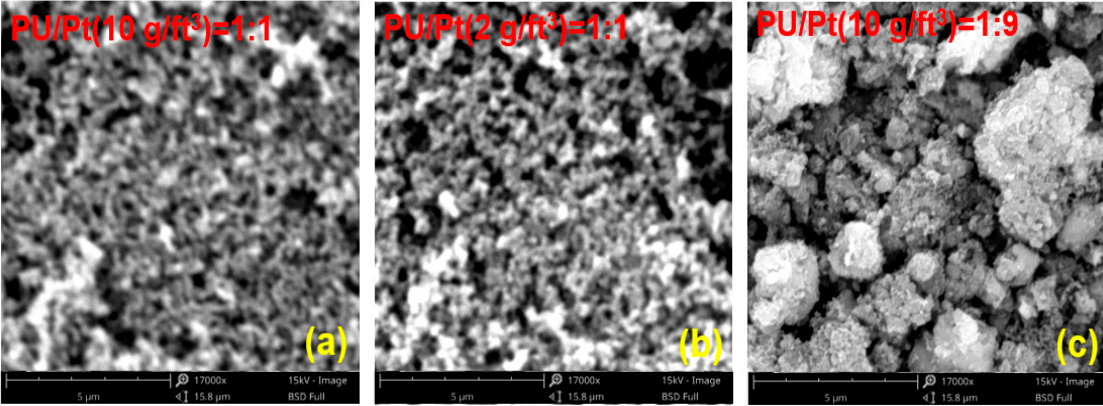
Figure 5. SEM diagrams in no aging experiments: ( a ) PU/Pt (10 g/ft 3 ) = 1:1; ( b ) PU/Pt(2 g/ft 3 ) = 1:1; ( c ) PU/Pt(10 g/ft 3 ) = 1:9.